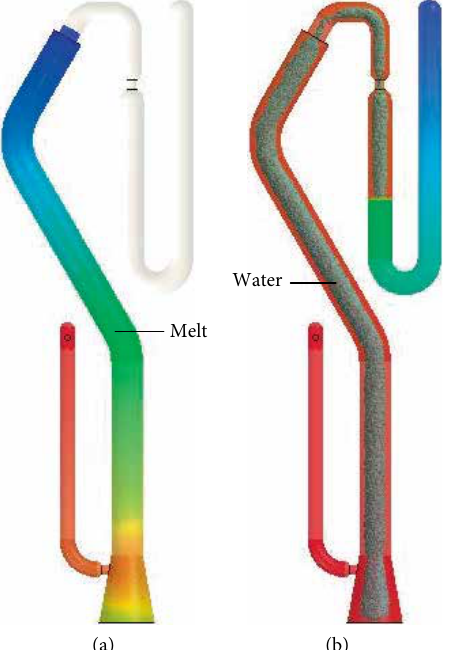
Figure 5: Simulation result and (a) melt filling stage, (b) water filling